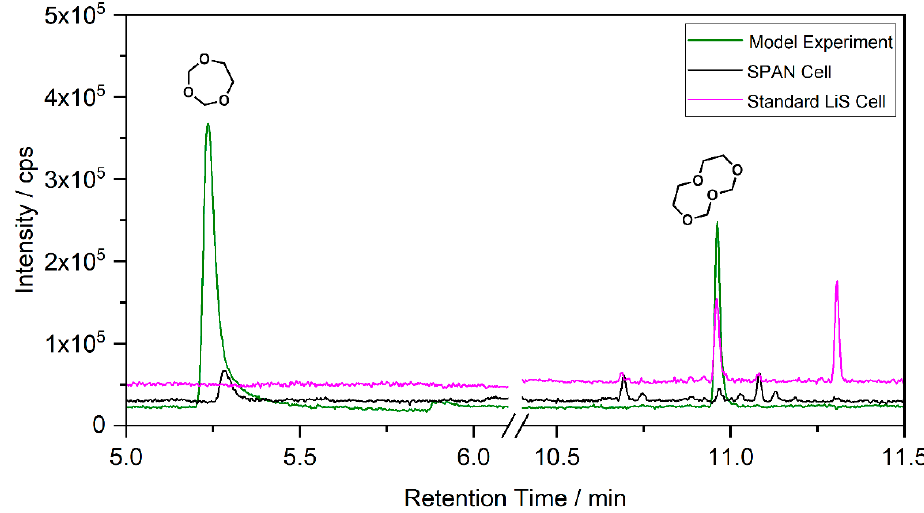
Figure 3. Chromatograms obtained by SPME–GC-MS from ether-based electrolytes used in LiS cell compared to the model experiment. Model experiment (green); SPAN cell with 1 mol/L LiTFSI in DOL/DME (black); standard LiS cell with additional LiNO 3 additive (0.25 mol/L; magenta).